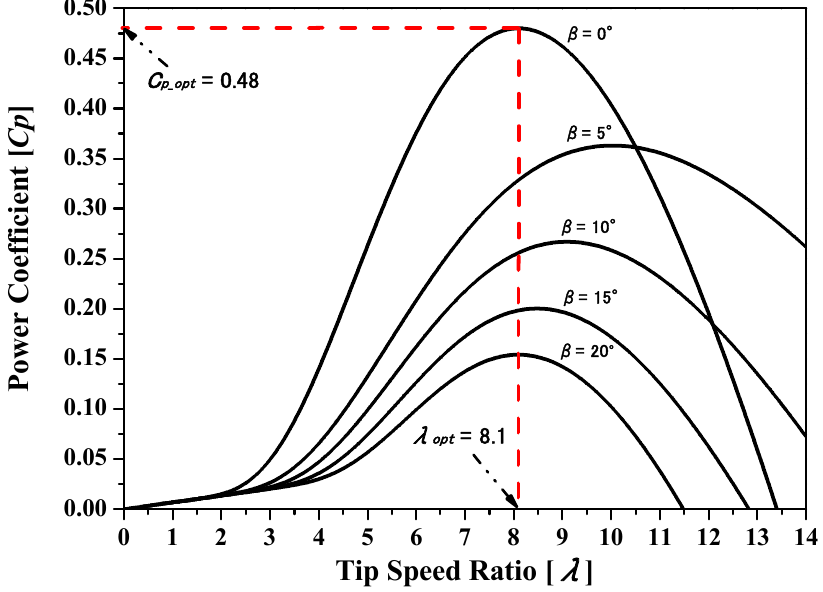
Figure 1. C p vs λ characteristics of the wind turbine for various pitch angles.